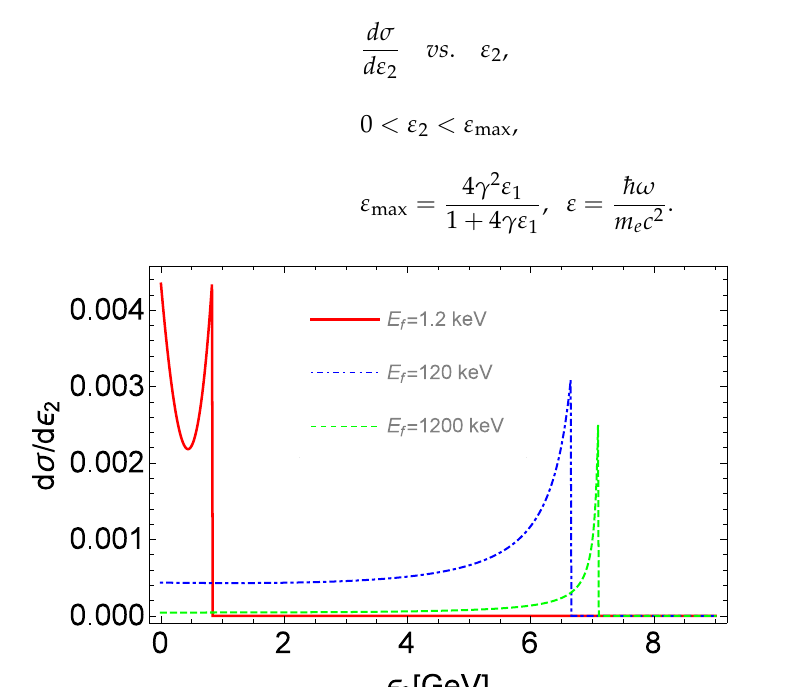
Figure 14. CBS differential cross section vs. ε 2 (given in GeV) for different energies of the laser pump (1.2 eV (continuous), 120 eV (dot-dash), 1200 keV